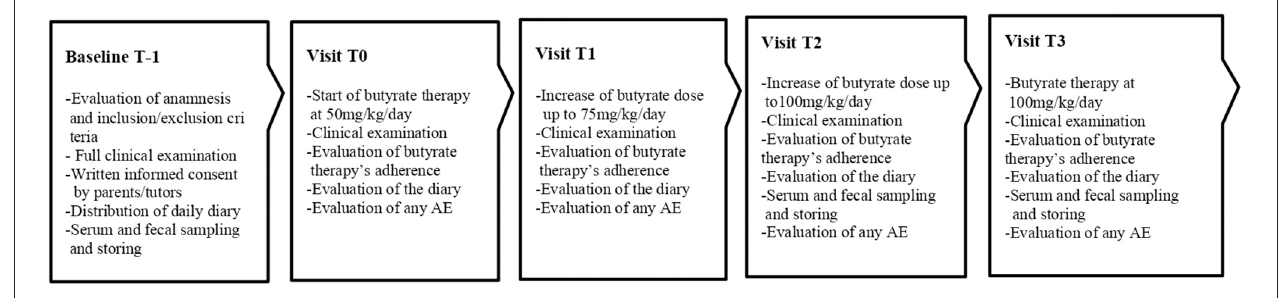
FIGURE 1 | The design of the step-up therapeutic approach study.